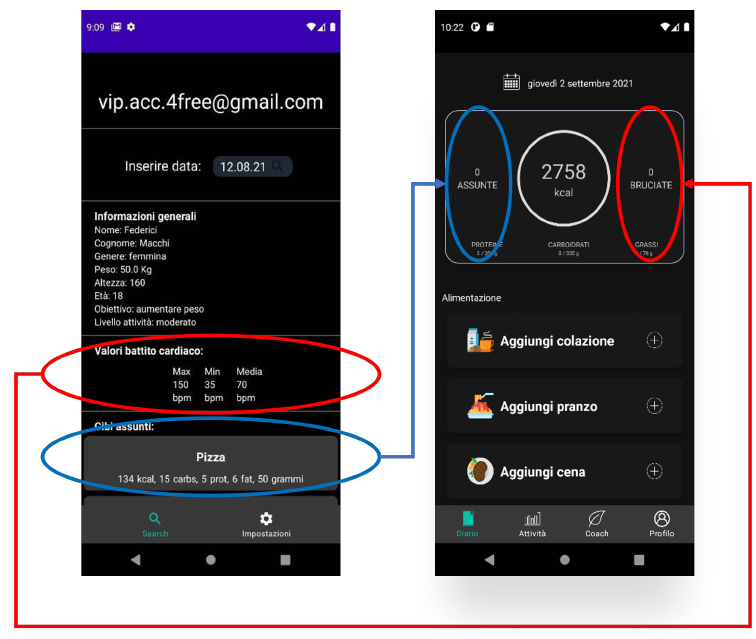
Figure 5. The GUI of the diet module of the PERCIVAL